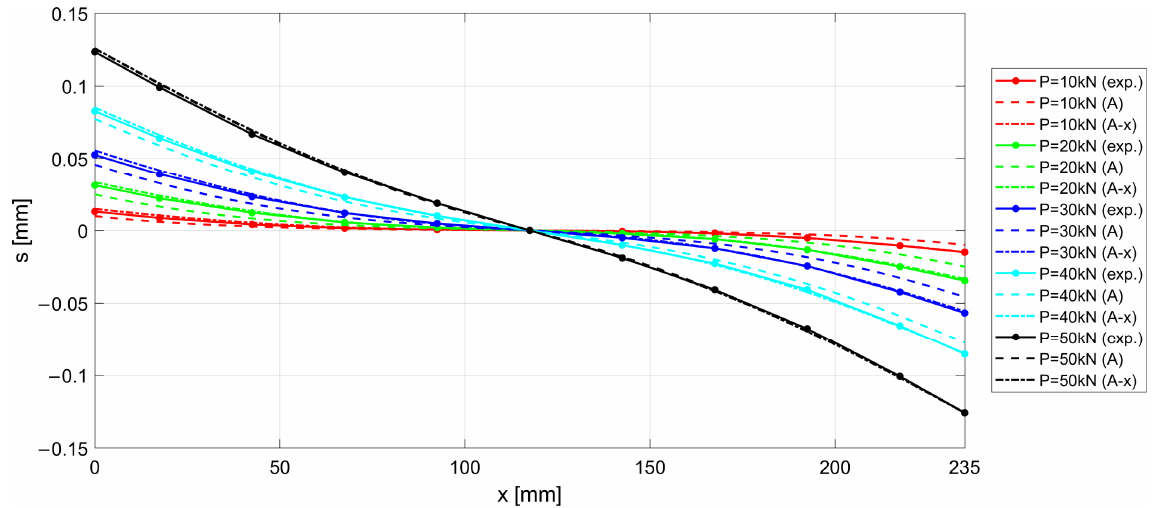
Figure 22. Experimental and numerical s − x for increasing load P . Two numerical formulations are presented, obtained by considering a fixed bond–slip model (A) and a model varying the abscissa (A-x).